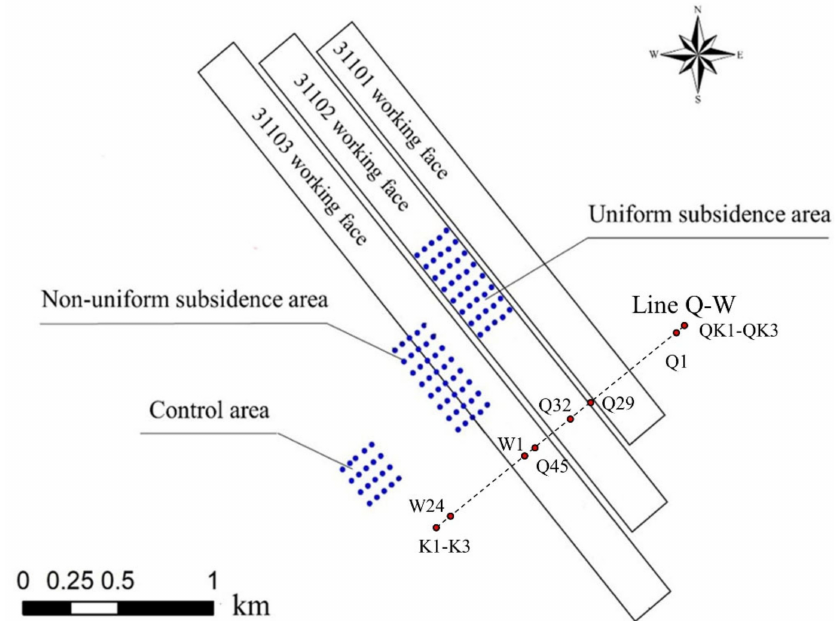
Figure 2. Layout of the sample points in the three areas.